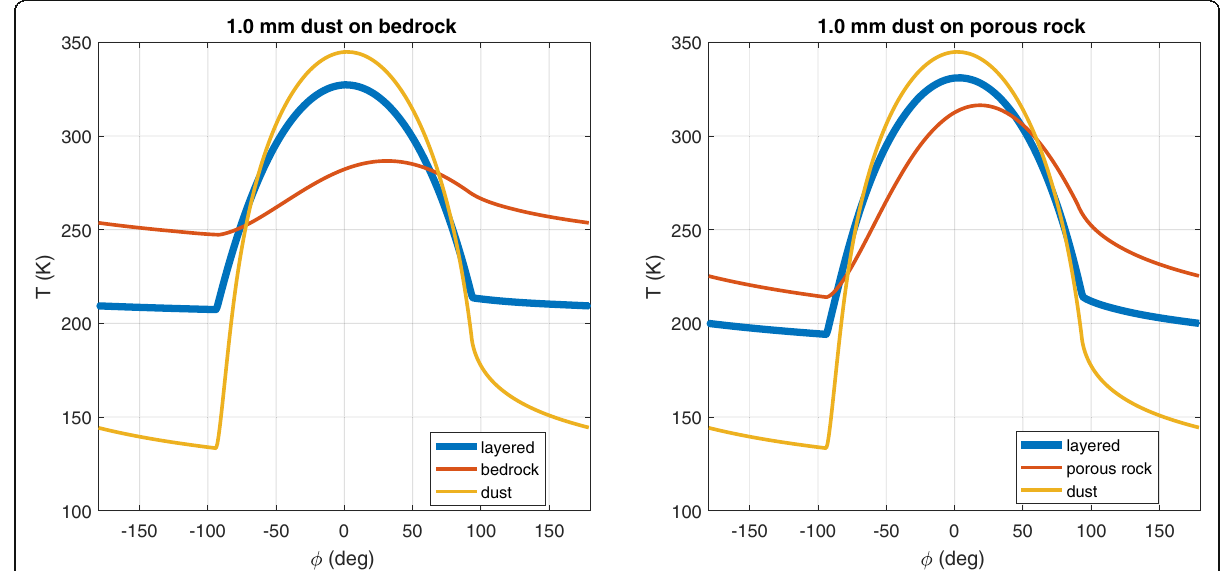
Fig. 2 Left: Example diurnal temperature curve (bold line) for bedrock covered with 1 mm of dust. Right: same as left, but for porous rock/coarse regolith covered with 1 mm of dust. The surface temperature curves for the homogeneous dust and subsurface material are shown for